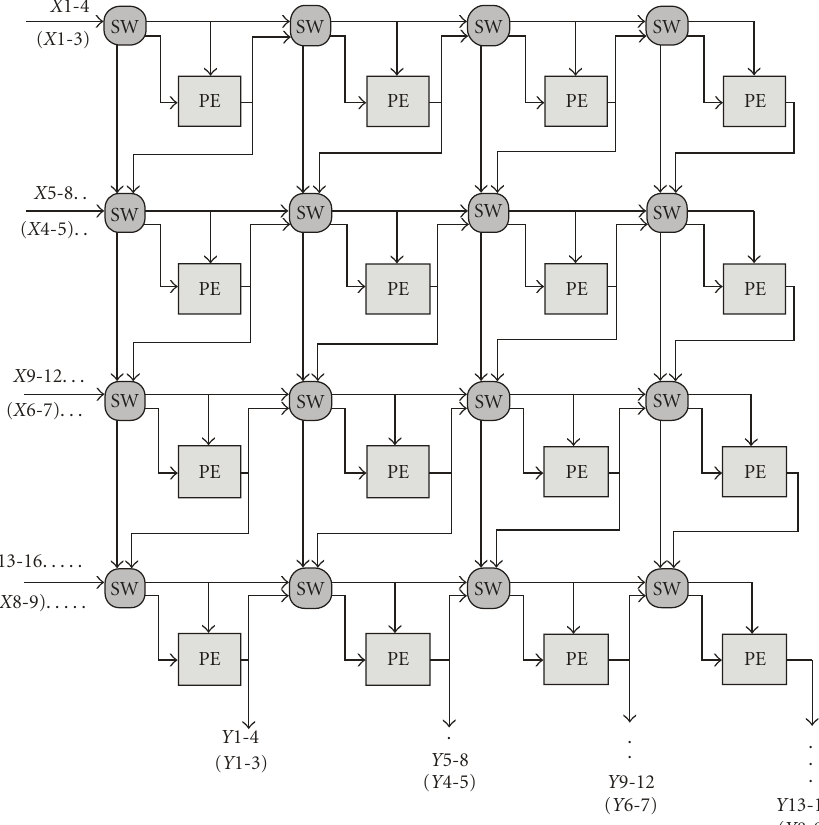
Figure 19: Circuit structure for parallel computation of 16- and 9-point DFTs.